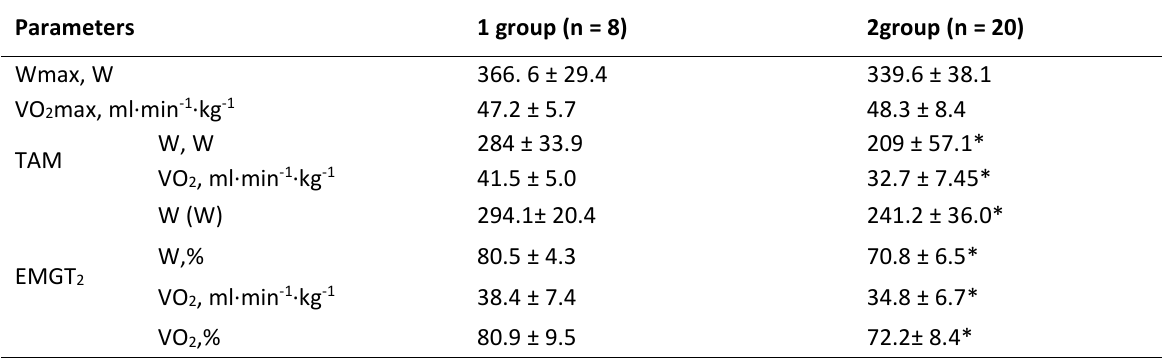
Table1. Power and oxygen consumption at TAM levels, EMGT 2 and VO 2 max in sportsmen with different aerobic potentials (Х±δ, n =